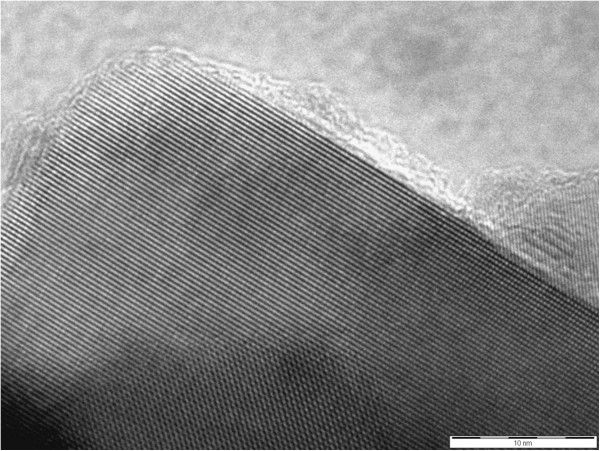
A TEM image of the Se-deposited nanocrystal TiO2electrode after annealing at 200°C.